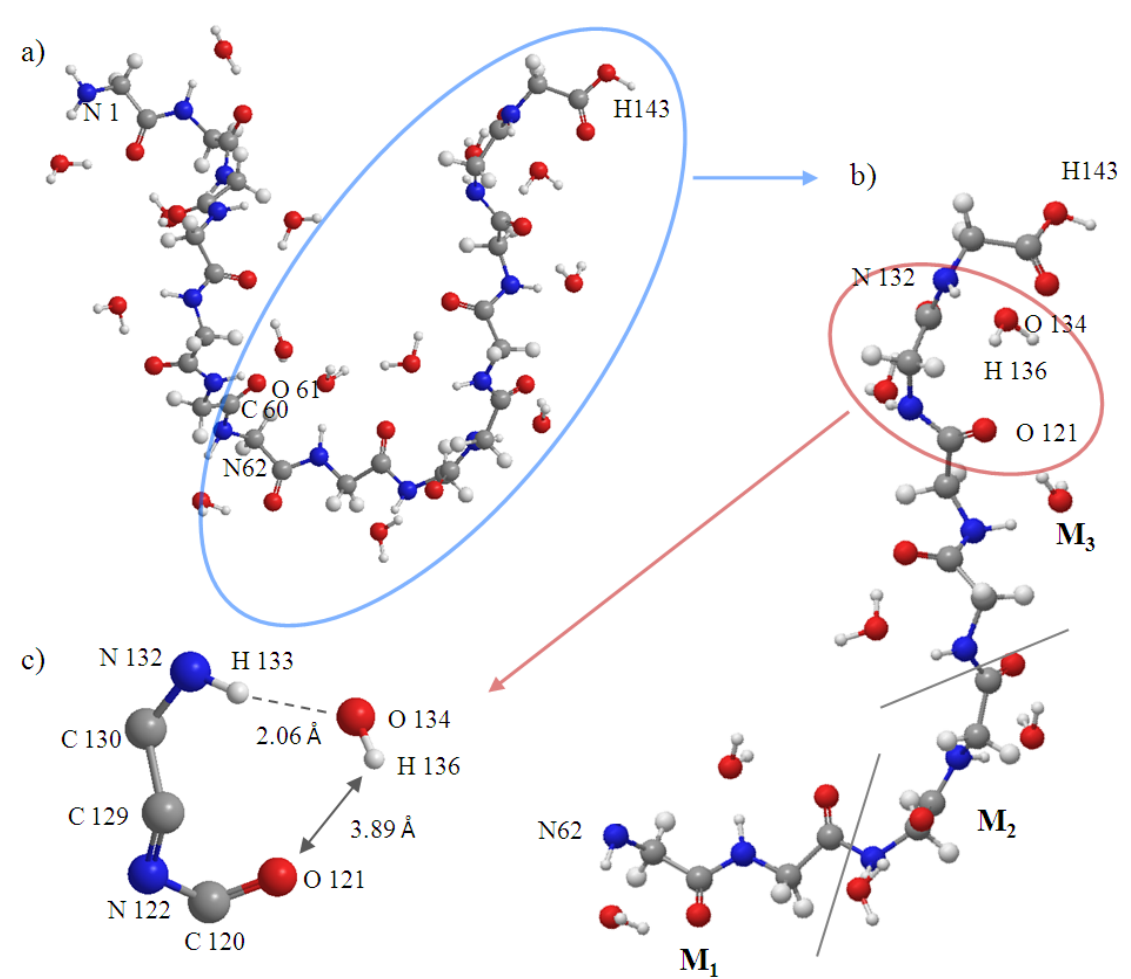
Figure 10. Snapshot at 5000fs of ( a ) entire peptide (Gly) the frozen region; atoms from 62 to 143 belong to the active region; ( b ) Interacting space (M , M and M ); and ( c ) 1 2 3